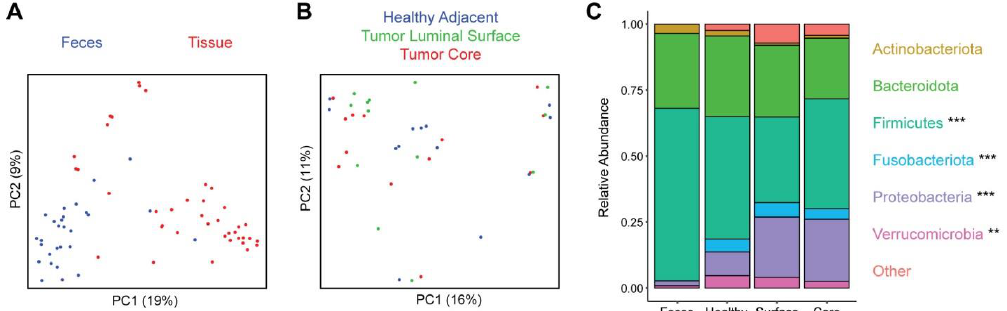
Figure 1. Distinct microbiota composition between feces and tissue sampling sites. ( A ) Microbial composition of fecal and tissue samples was visualized by principal coordinates analysis (PCoA). Each dot represents one sample, with fecal samples in blue and tissue samples in red. Axes show the first and second coordinates with the percent variation explained by these coordinates. ( B ) PCoA plot of tissue samples, colored by the sample site: healthy adjacent (blue), tumor luminal surface (green), and tumor core (red). ( C ) Phylum level taxonomic summary plot showing relative abundances of major phyla present in fecal and tissue samples. Phyla that were significantly differentially abundant between feces and the three tissue sites are indicated with asterisks (** q < 0.01, *** q < 0.001).